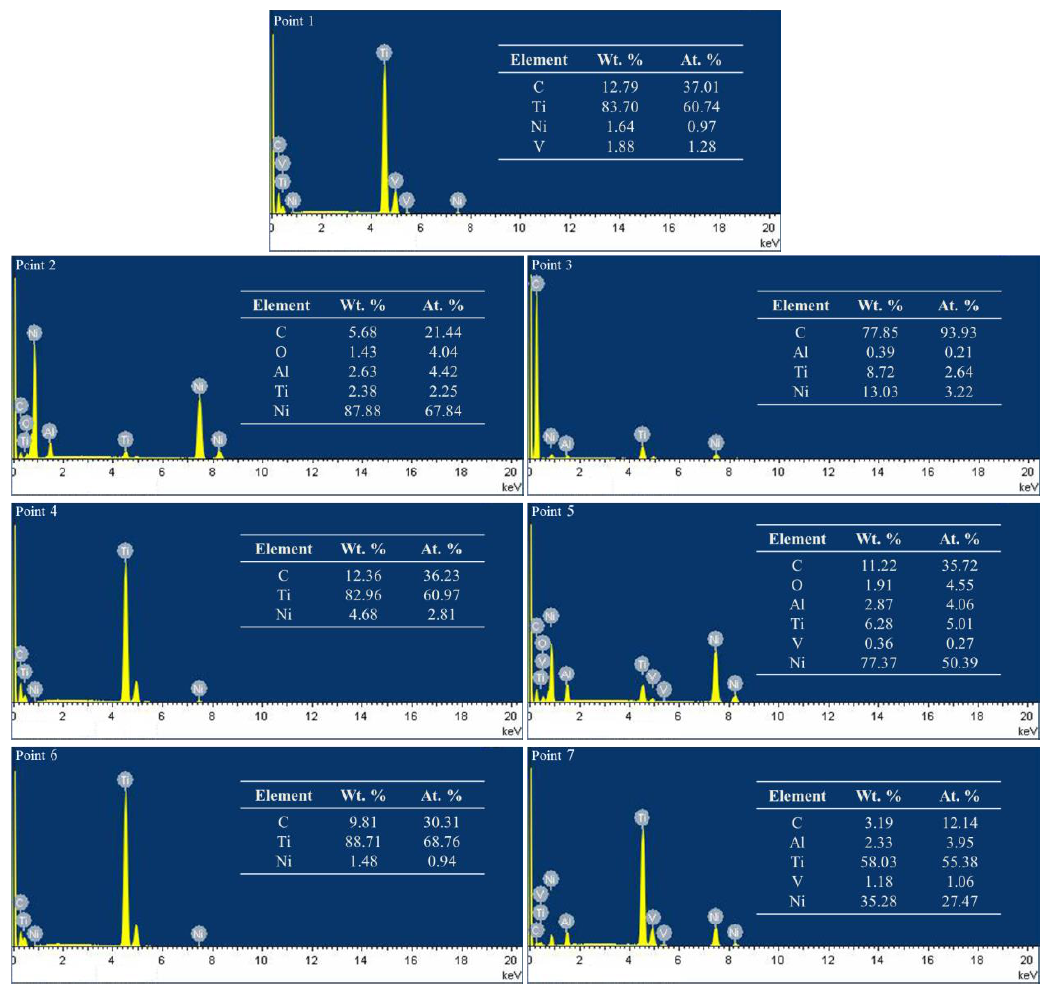
Figure 4. EDS results of the points in Figure 3. Leaner y axis with the full scale of 8236 cts for all the EDS spectra.